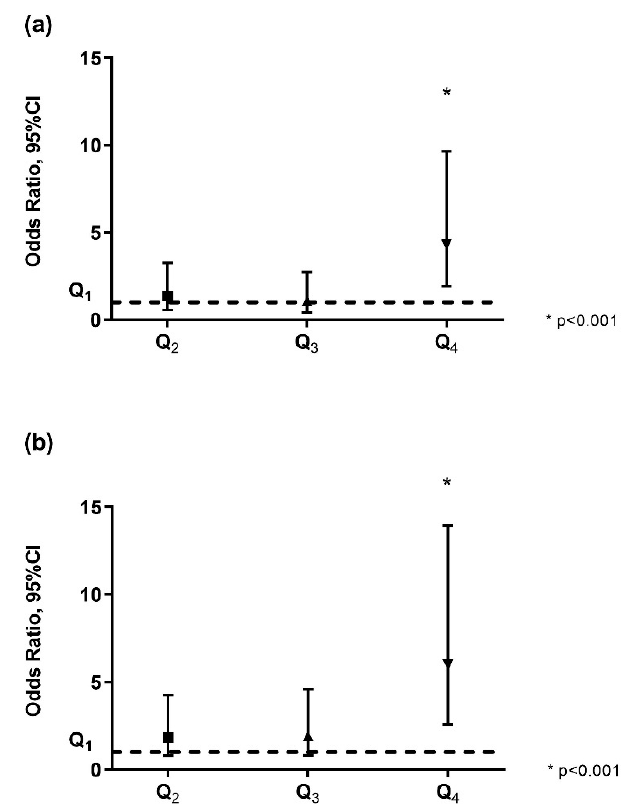
Figure 2. Association of quartiles of palmitoleic acid and SCD-16 to overweight / obesity. Association of quartiles of palmitoleic acid ( a ) and SCD-16 ( b ) to overweight / obesity. Legend: CI: confidence interval; Q1: 1st quartile; Q2; 2nd quartile; Q3: 3rd quartile; Q4: 4th quartile.